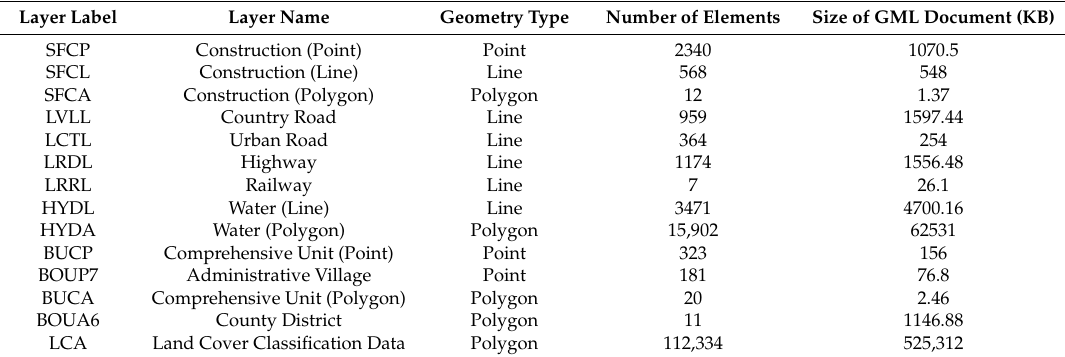
Table 4. Information of WFS layers of experimental data.